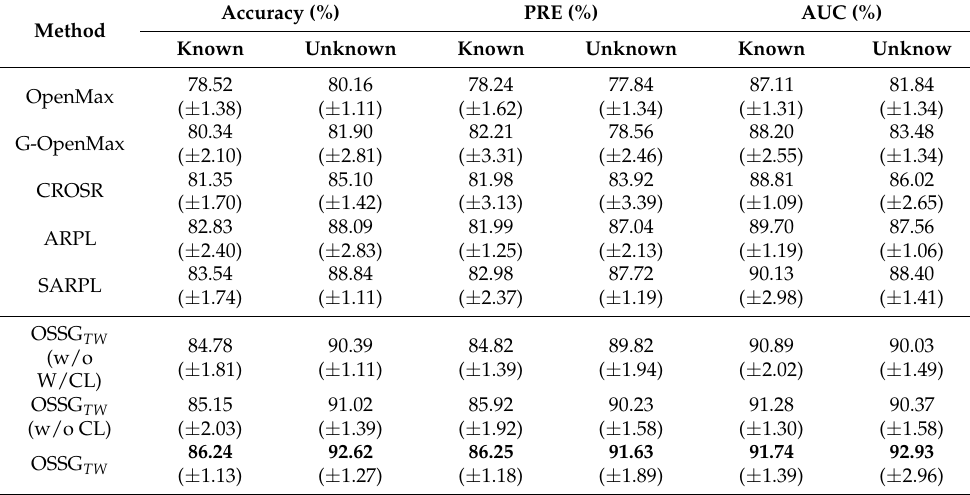
Table 2. The results of the radios.